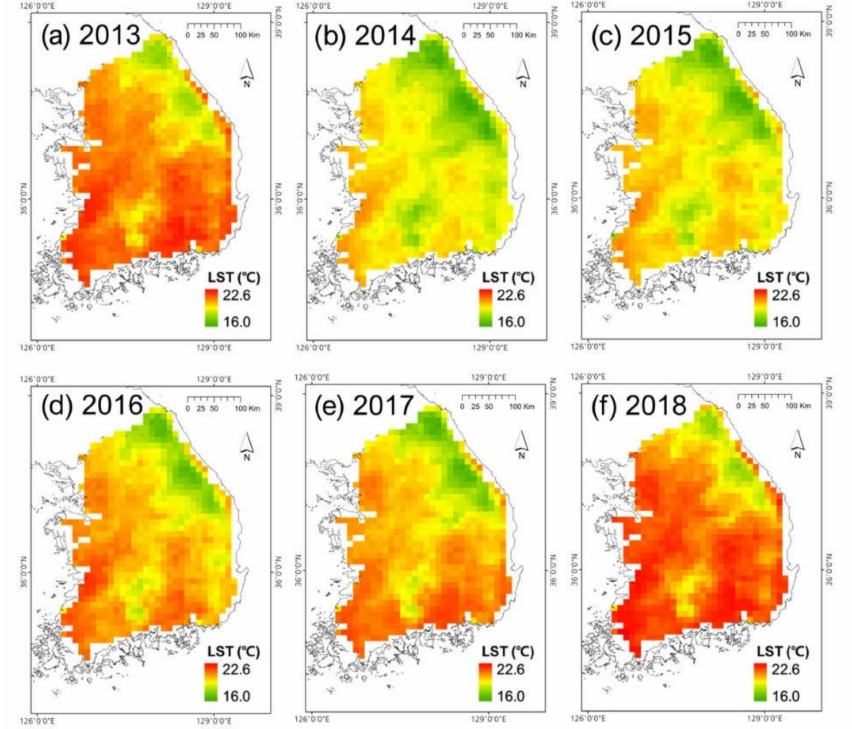
Figure 8. Spatial distribution maps of average estimated all-weather 10 km LSTs for scheme 1(S1) during July and August for each year; 2013 ( a ) to 2018 ( f ) for